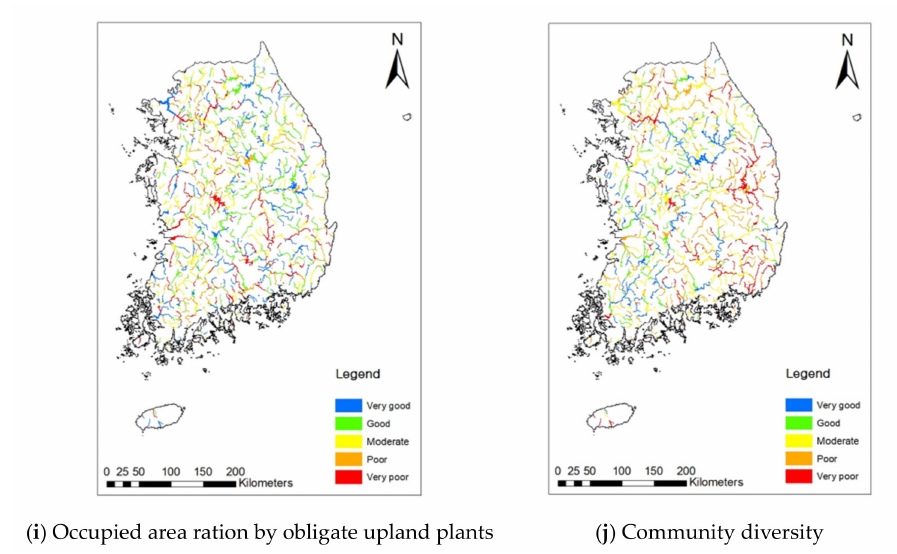
Figure 1. Nation-wide distribution of the grades based on each vegetation component and the riparian vegetation index of rivers in South